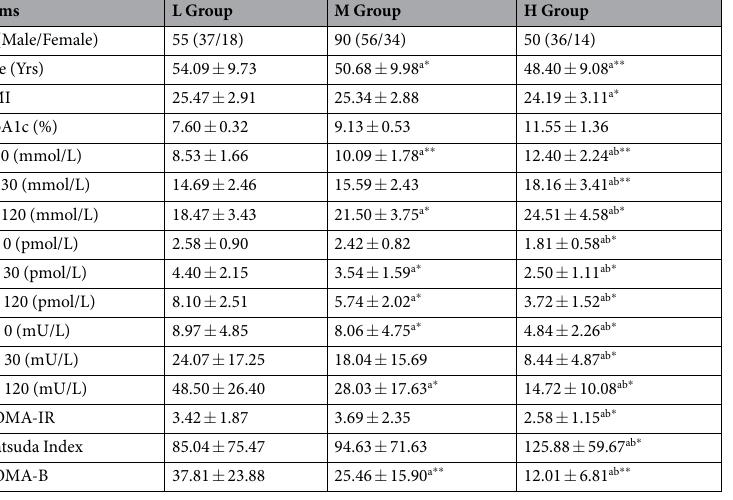
Table 1. Baseline for the study subjects. Data are presented as the means ± SD. L group: Lower HbA 1c values group, M group: Moderate HbA 1c values group, H group: higher HbA 1c values group, a * compared with the L Group ( P < 0.05), a ** compared with M Group ( P < 0.01), b * compared with M Group ( P < 0.05), b ** compared with M Group ( P < 0.01), Bg 0: blood glucose concentrations before glucose loading, Bg 30: blood glucose concentrations at 30 min after glucose loading, Bg 120: blood glucose concentrations at 120 min after glucose loading, Cp 0: serum C-Peptide concentrations before glucose loading, Cp 30: serum C-Peptide concentrations 30 min after glucose loading, Cp 120: serum C-Peptide concentrations 120 min after glucose loading, Ins 0: serum insulin concentrations before glucose loading, Ins 30: serum insulin concentrations 30 min after glucose loading, Ins 120: serum insulin concentrations 120 min after glucose loading.